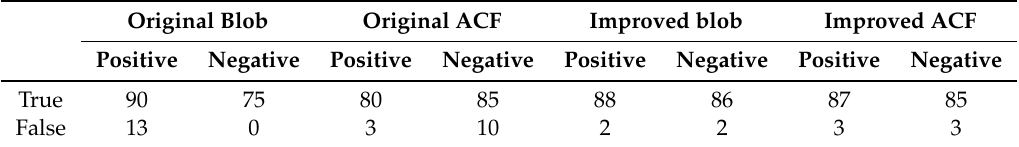
Table 1. Summarized results for the blob-based and the ACF-based original algorithms, as well as for the improved blob-based and improved ACF-based algorithms.